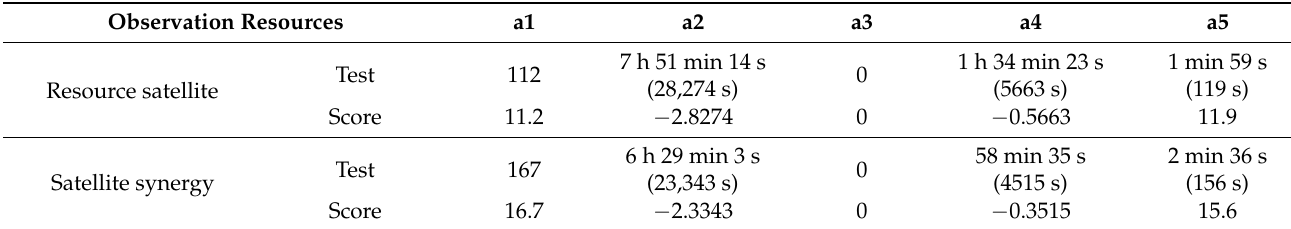
Table 4. Improvement of target observation capability.